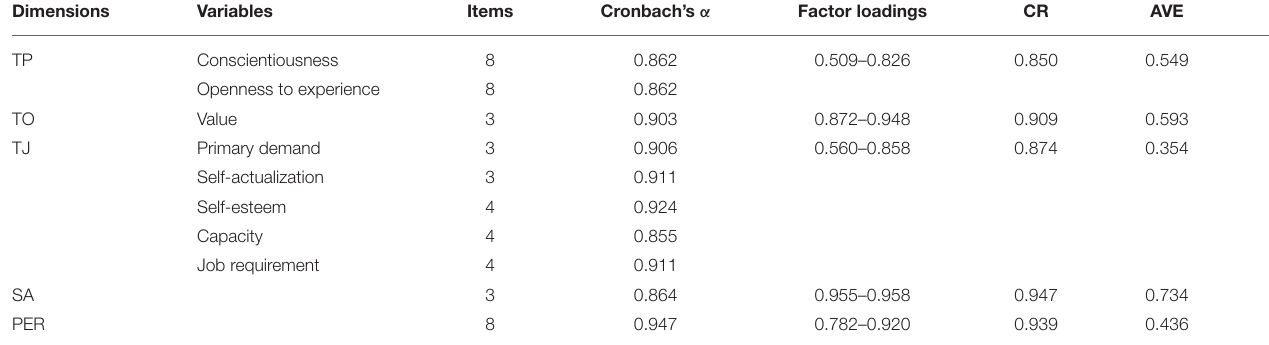
TABLE 5 | Reliability and